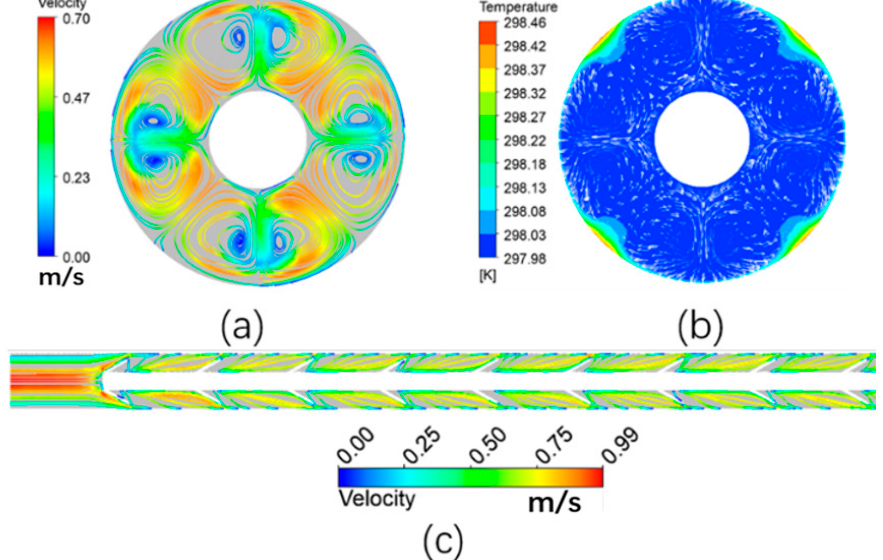
Figure 5. Temperature contour and streamline on plane at z = 60 mm ( P = 5 mm, A = 30, N = 4): ( a ) longitudinal swirls generated in tube, ( b ) temperature distribution, ( c ) the effect of deflecting flow caused by deflectors, streamline.